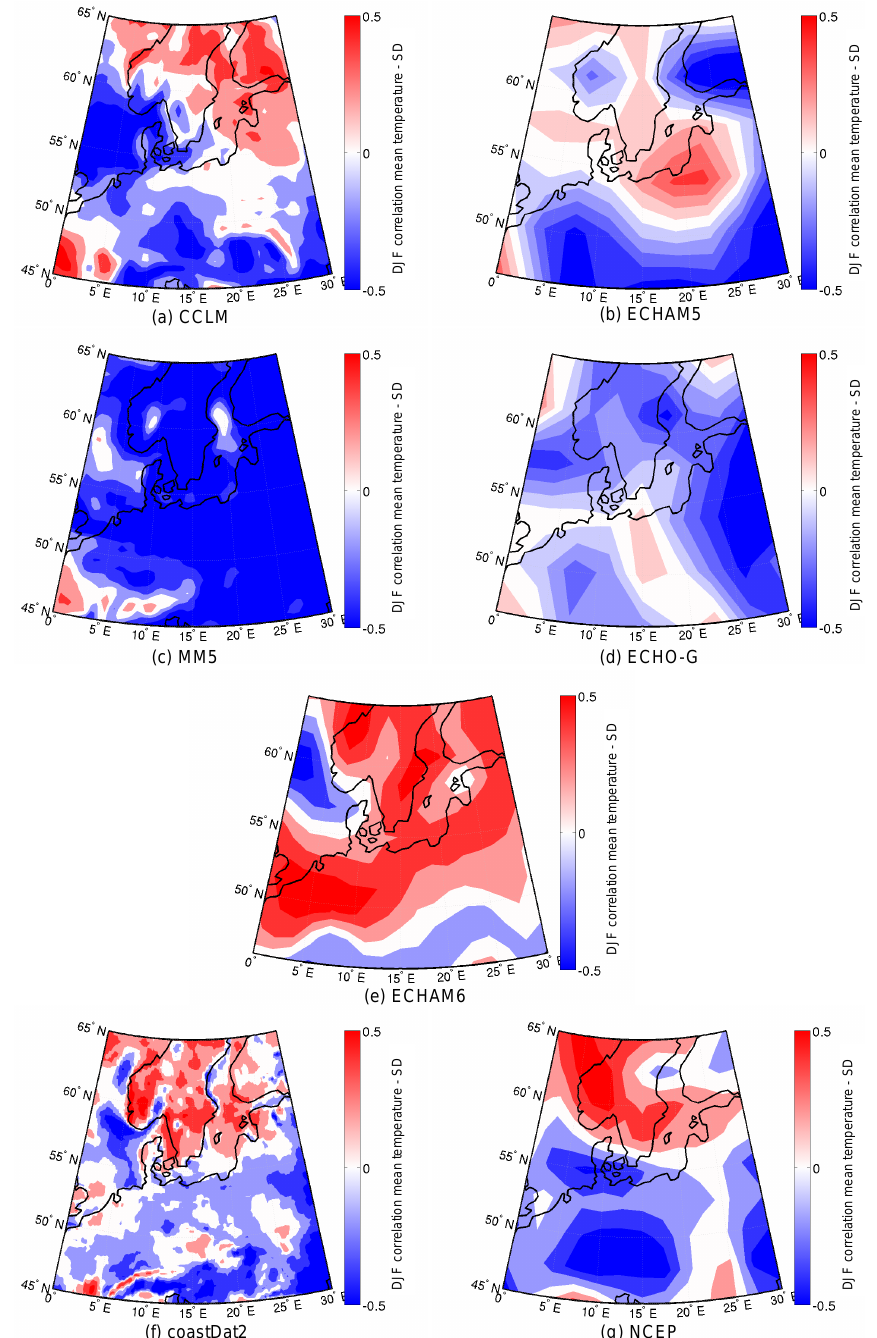
Figure 8. Correlation between field mean Temperature and SD of wind speed for seven different data sets in the overlapping time period from 1948 to 1990: (a) CCLM, (b) ECHAM5, (c) MM5, (d) ECHO-G, (e) ECHAM6, (f) coastDat2, (g)